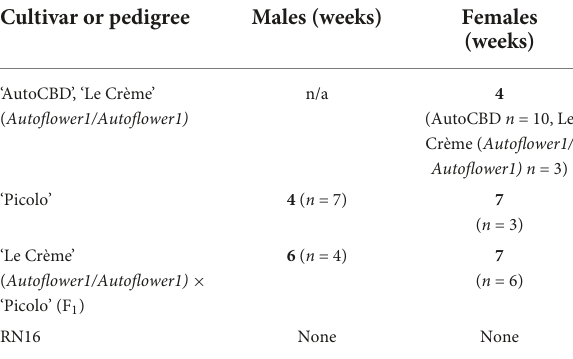
TABLE 4 Time to flower under long day (16L:8D) lighting. Cultivar or pedigree